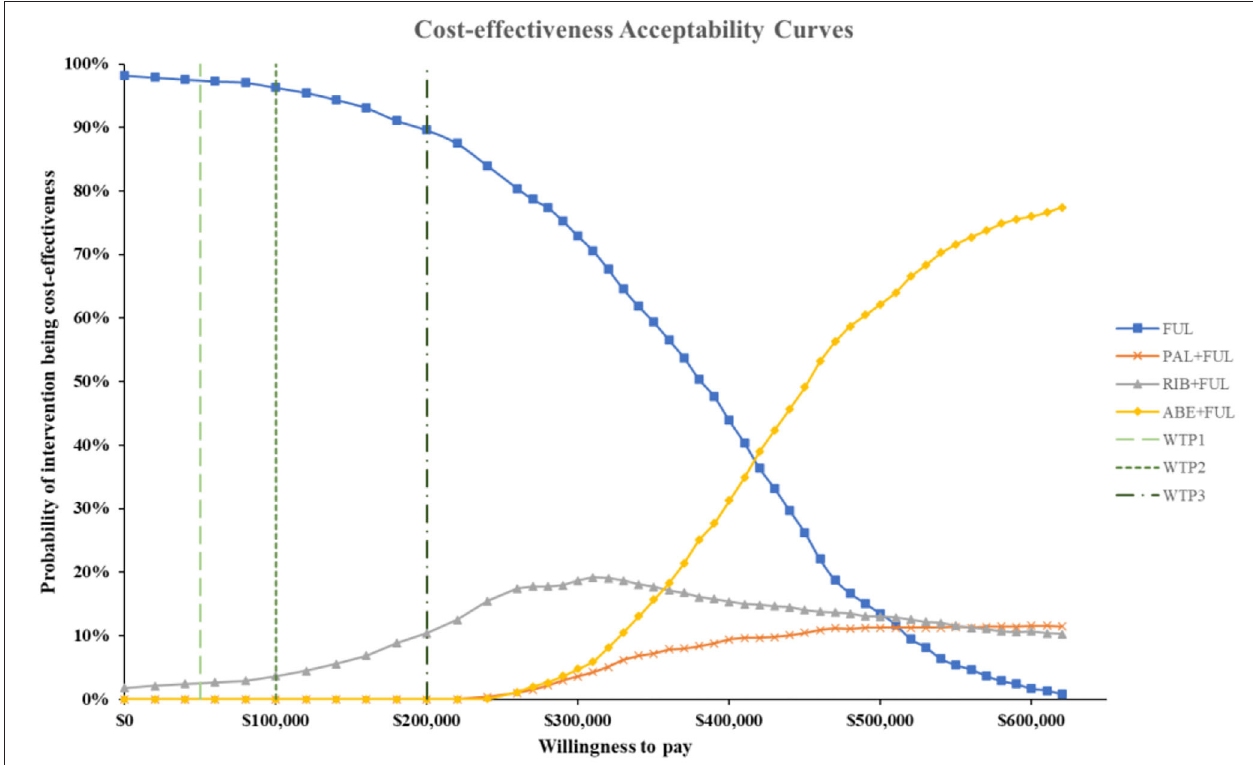
FIGURE 8 | Cost-effectiveness acceptability curves for abemaciclib plus fulvestrant vs. palbociclib plus fulvestrant, ribociclib plus fulvestrant and fulvestrant monotherapy. ABE, abemaciclib; RIB, ribociclib; PAL, palbociclib; FUL, fulvestrant; WTP1, $50,000; WTP2, $100,000; WTP3,